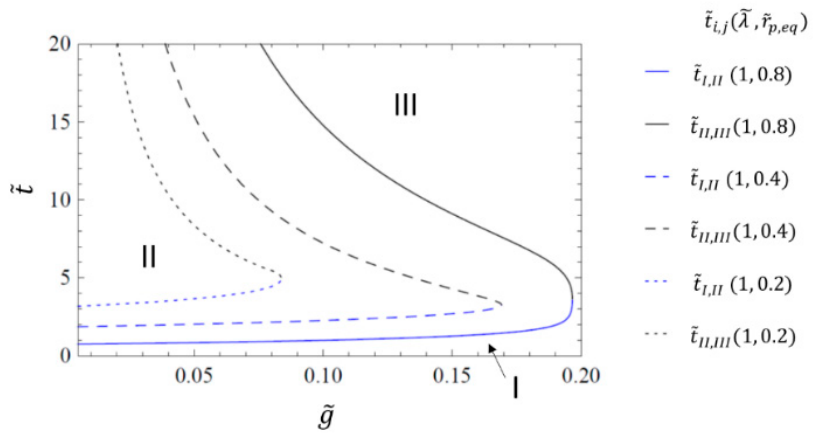
Figure 6. Transition times 𝑡̃ (cid:3010),(cid:3010)(cid:3010) (blue lines) and 𝑡̃ (cid:3010)(cid:3010),(cid:3010)(cid:3010)(cid:3010) (black lines) as a function of gas transfer rate 𝑔(cid:3556) for the transfer coefficient model, with a relaxation time of 𝜆(cid:4634) = 1 and different values of 𝑟̃ (cid:3043),(cid:3032)(cid:3044) . The quantities in the legend are arranged as (𝜆(cid:4634),𝑟̃ (cid:3043),(cid:3032)(cid:3044) ) . The three pore collapse regimes are indicated by I, II and III.